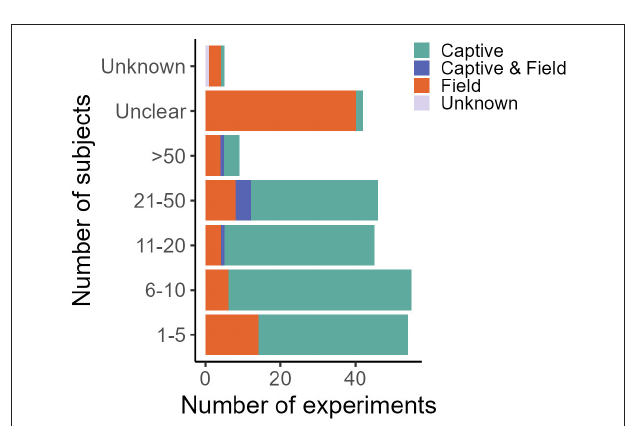
FIGURE 4 | Number of subjects in captive and field experiments. One experiment is defined as a unique species, food, novelty and/or substance (application) combination. One publication can thus comprise several experiments. Sample size in field studies compared to captive studies is disproportionally often “unclear” due to lack of individual-based data. The classification of “unknown” was given to studies for which the information could not be accessed. Studies were retrieved via systematic search and ad hoc retrievals (see